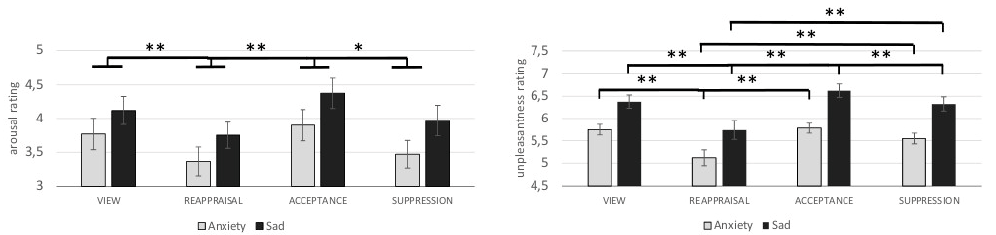
Figure 2. Differential effects (mean and standard errors) of emotion regulation (ER) strategies for anxiety- and sadness-inducing pictures on SAM (Self Assessment Manakin) ratings of arousal (left) and unpleasantness (right). * p (FDR) < 0.05; ** p (FDR) < 0.01